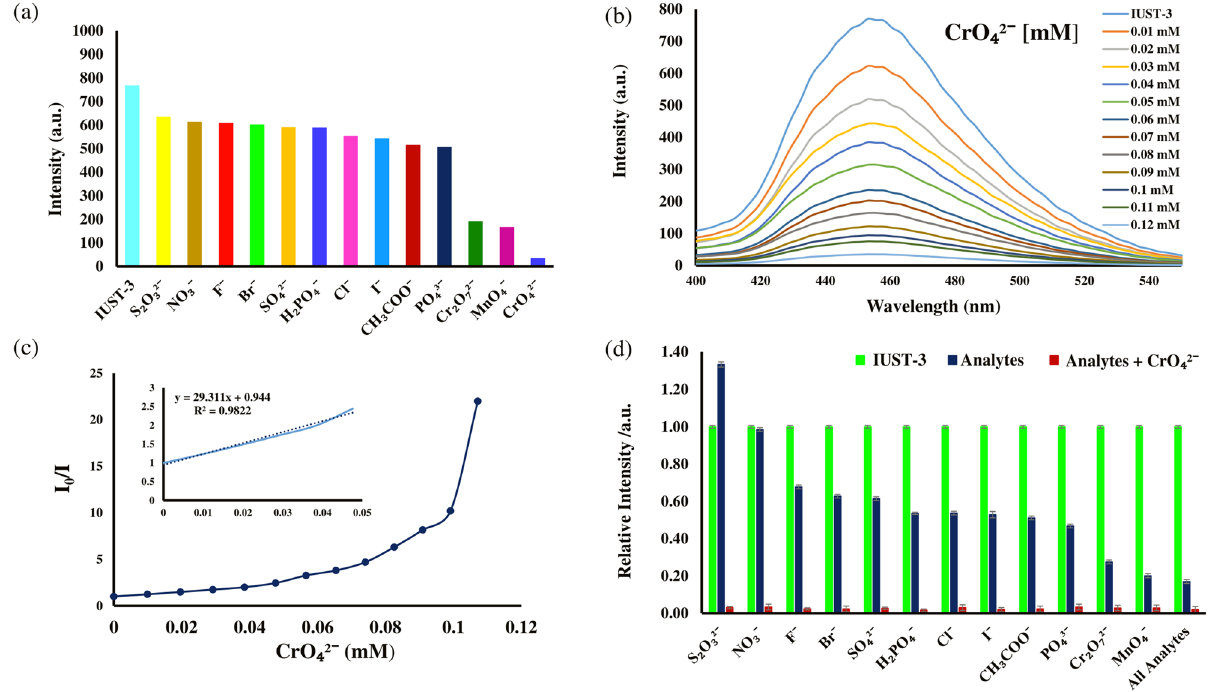
Figure 5. ( a ) The comparison of the fluorescence quenching intensity of the IUST-3 (1 mg) in water (2 ml) among the different anions (1 mM, 100 µl), ( b ) Photoluminescence spectra of the IUST-3 with gradual addition of the CrO 4 2− anion (1 mM, 10 µL addition each time), ( c ) Stern–Volmer plot of I 0 /I versus the CrO 4 2− anion concentration in the IUST-3 aqueous suspension (insert: enlarged view of a selected area), (d) Selective detection of the CrO 4 2− anion on the IUST-3 in the presence of different aromatic compounds in water.